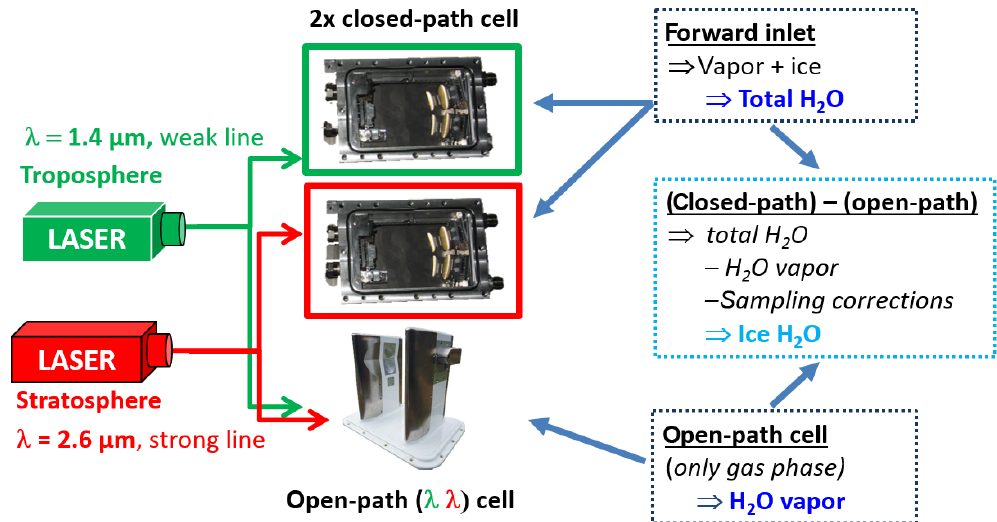
Figure 4. Schematic of HAI’s working principle in the multi-phase configuration. By combining selective open-path gas-phase measurements with total water measurements in closed-path extractive cells (ice and droplets are evaporated by heated inlet lines before reaching the cells), it is possible to derive the ice water content from the difference between closed-path and open-path